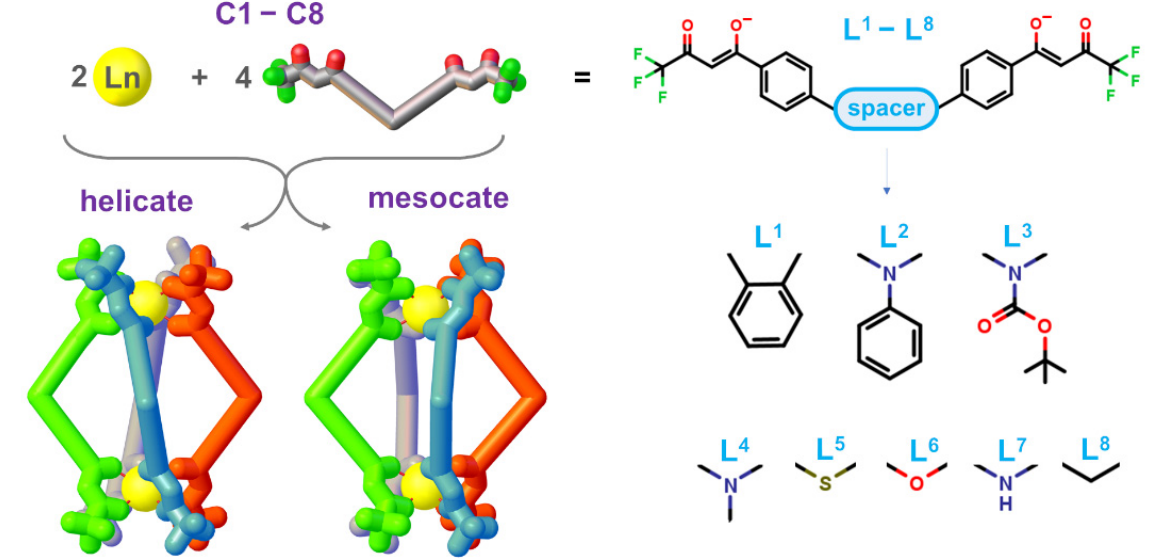
Figure 1. [Ln 2 L 4 ] 2 − cages in the helicate and mesocate forms and general formula of the bis- β - diketone ligands L 1 − L 8 with the different considered spacers.